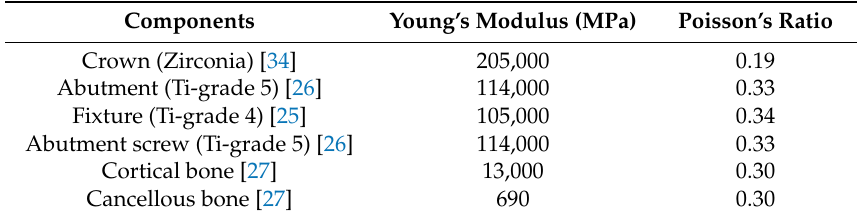
Figure 2. Modeling of three-dimensional finite element for single surgical model. ( a ) Geometry data extraction from CBCT images, ( b ) reconstruction of surface and volume for mandible bone, and ( c ) finite element single surgical model for conventional and separable fixtures. Table 1. Material properties of finite element models.